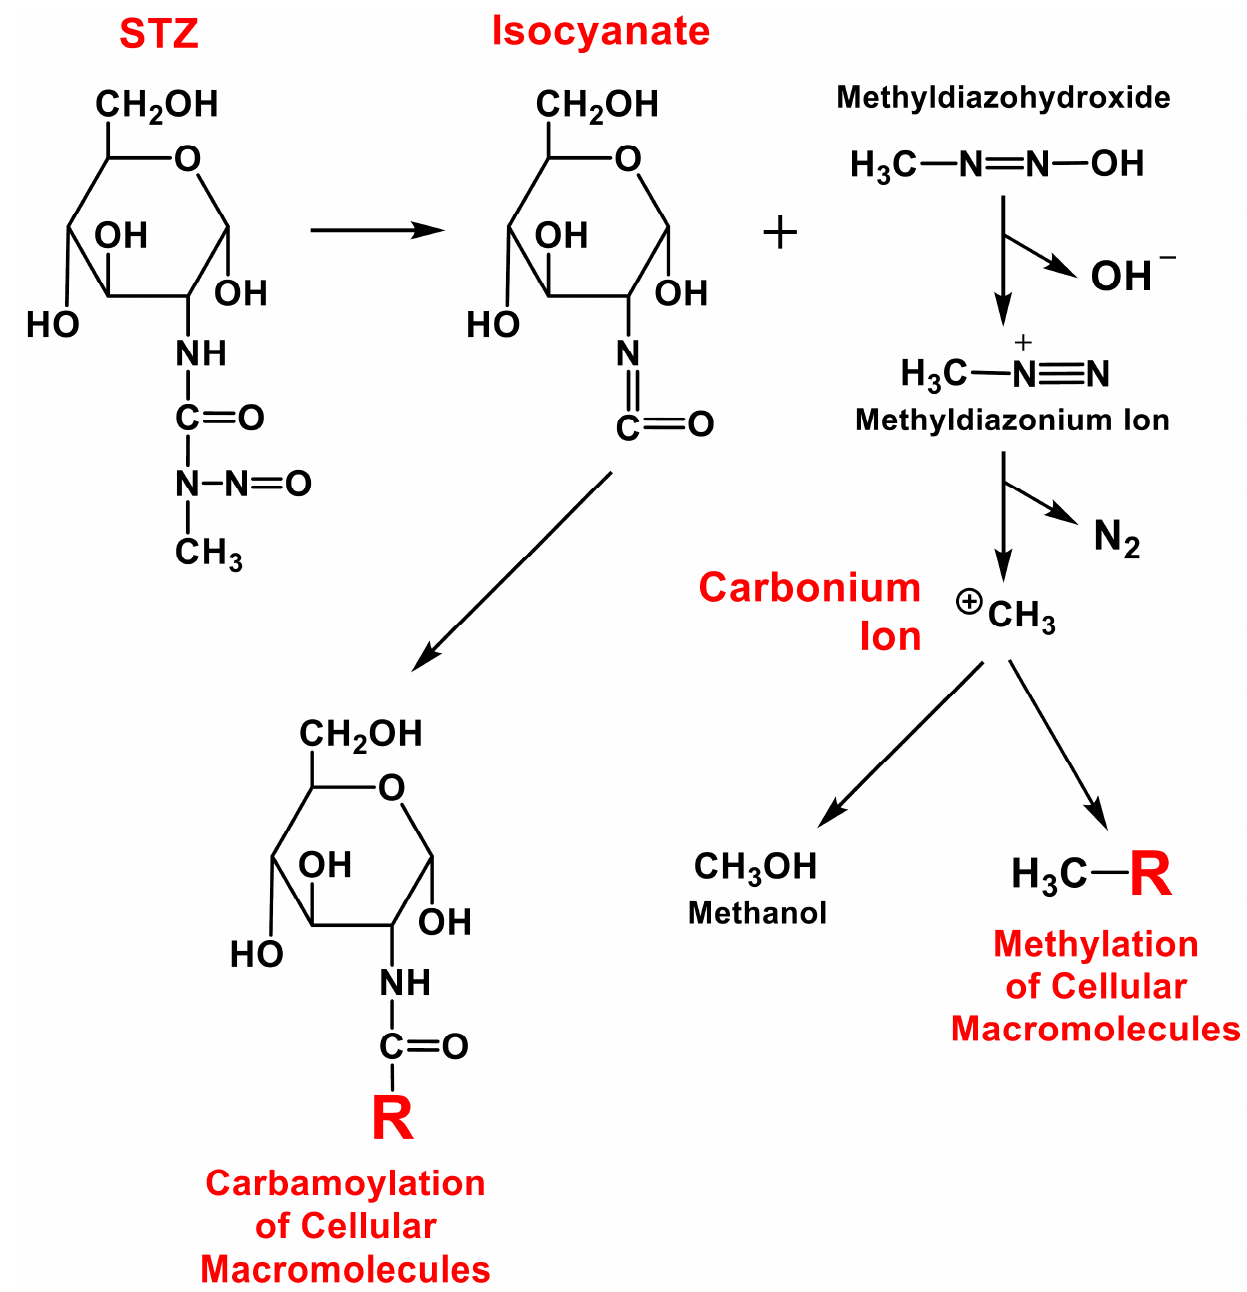
Figure 2. A proposed hypothesis on the potential role of STZ in the pathogenesis of autoimmune T1DM in humans. A detailed description of the hypothesis is provided in the main text under Sec- tion 2 (“Hypothesis”).